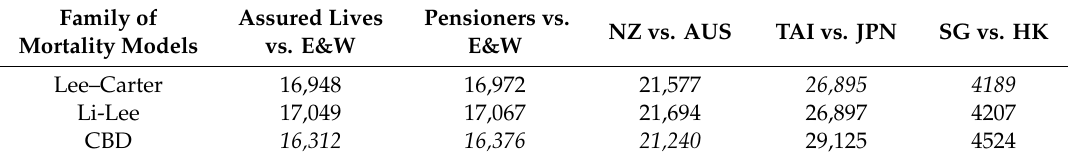
Table 1. BIC values of fitting three two-population mortality projection models to di ff erent datasets. Family